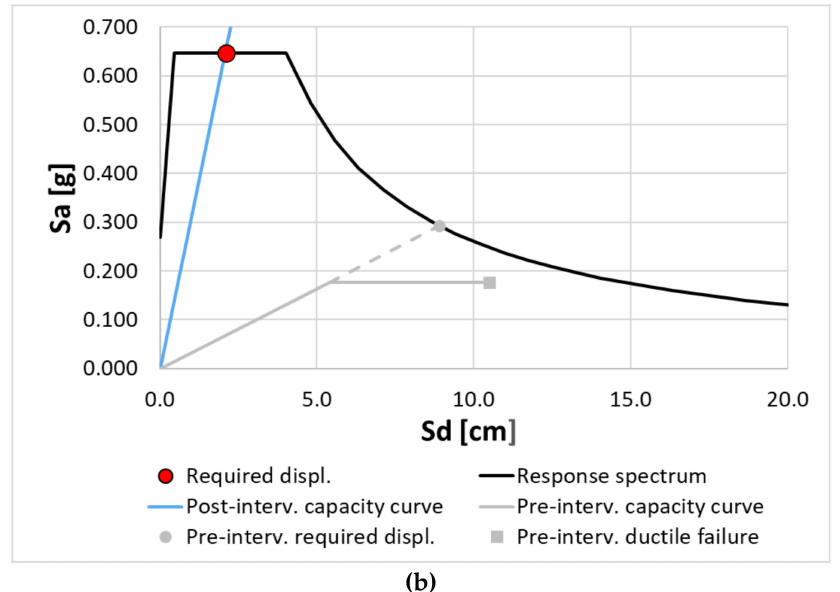
Figure 11. ADRS plane: ( a ) modal_y; ( b ) accel_y.